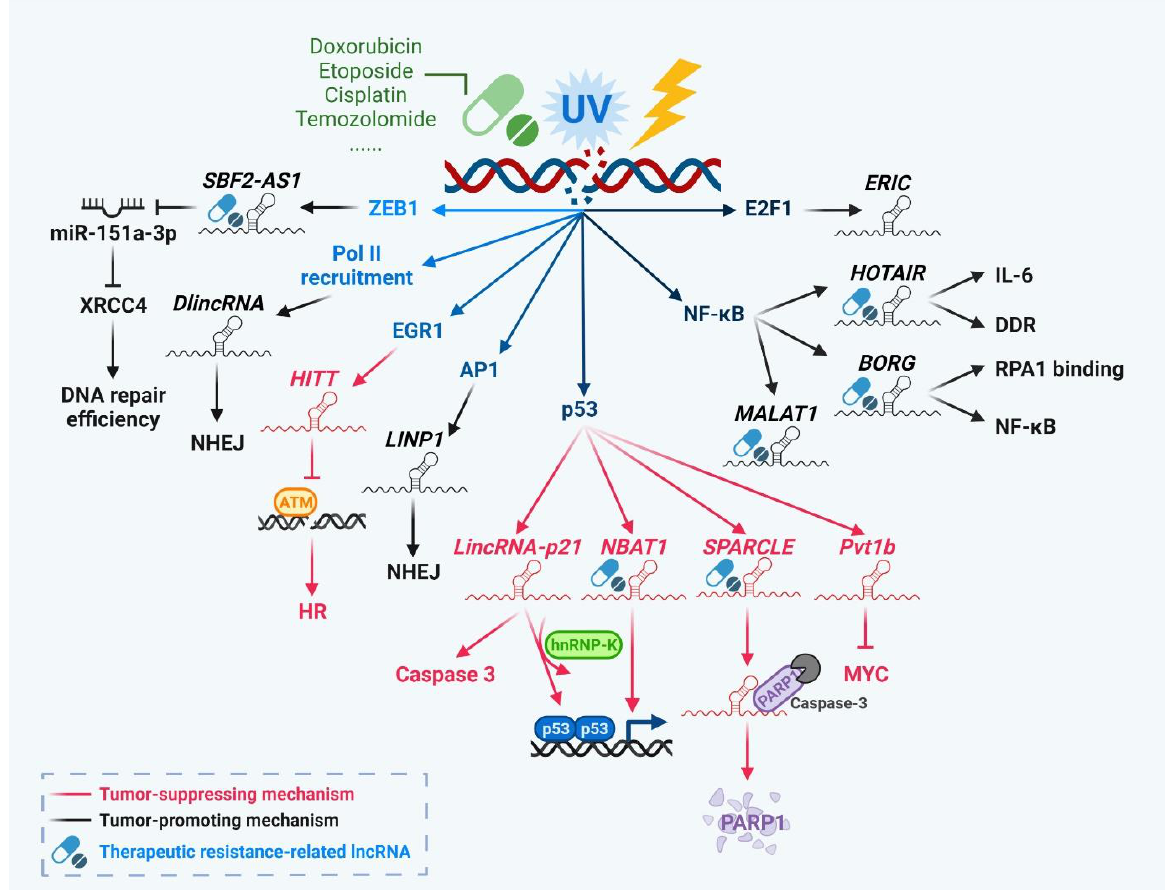
Figure 1. LncRNAs play multiple roles in DNA damage response (DDR) to address genotoxic stress. Under exogenous genotoxic agent-mediated DNA damage, lncRNAs are involved in a variety of regulatory roles of DDR and modulate cell fates. The key upstream transcription factors of each distinct lncRNA and the downstream targeted mechanisms or the related cellular processes are summarized. LncRNAs that particularly impact therapeutic susceptibility are marked. AP1 (activator